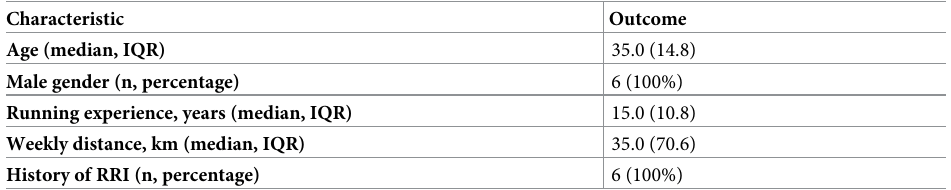
Table 1. Characteristics of focus group